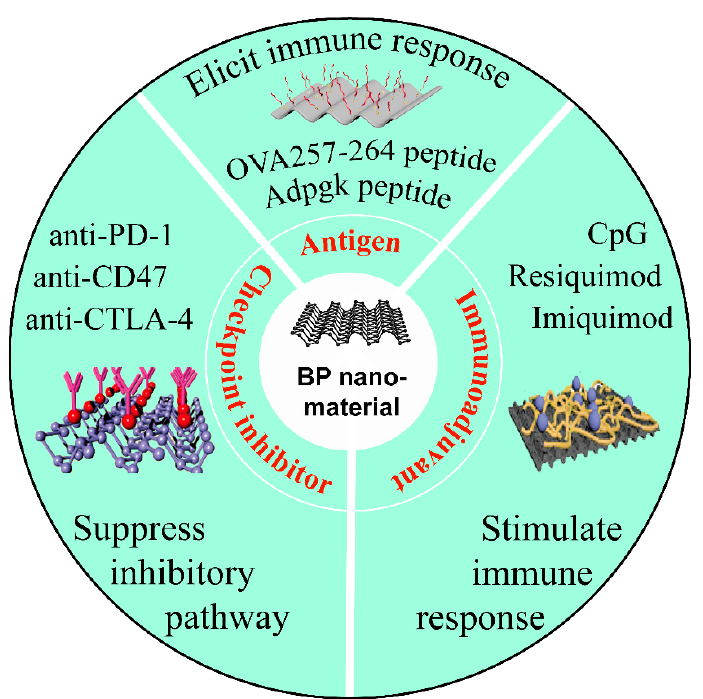
Figure 5. Schematic illustration of the delivery of immunotherapeutic agents through BP nanomaterials in cancer immunotherapy. The checkpoint inhibitor, antigen, and immunoadjuvant are three main types of immunotherapeutic agents which can be loaded on BP nanomaterials to elicit distinct effects for cancer immunotherapy.